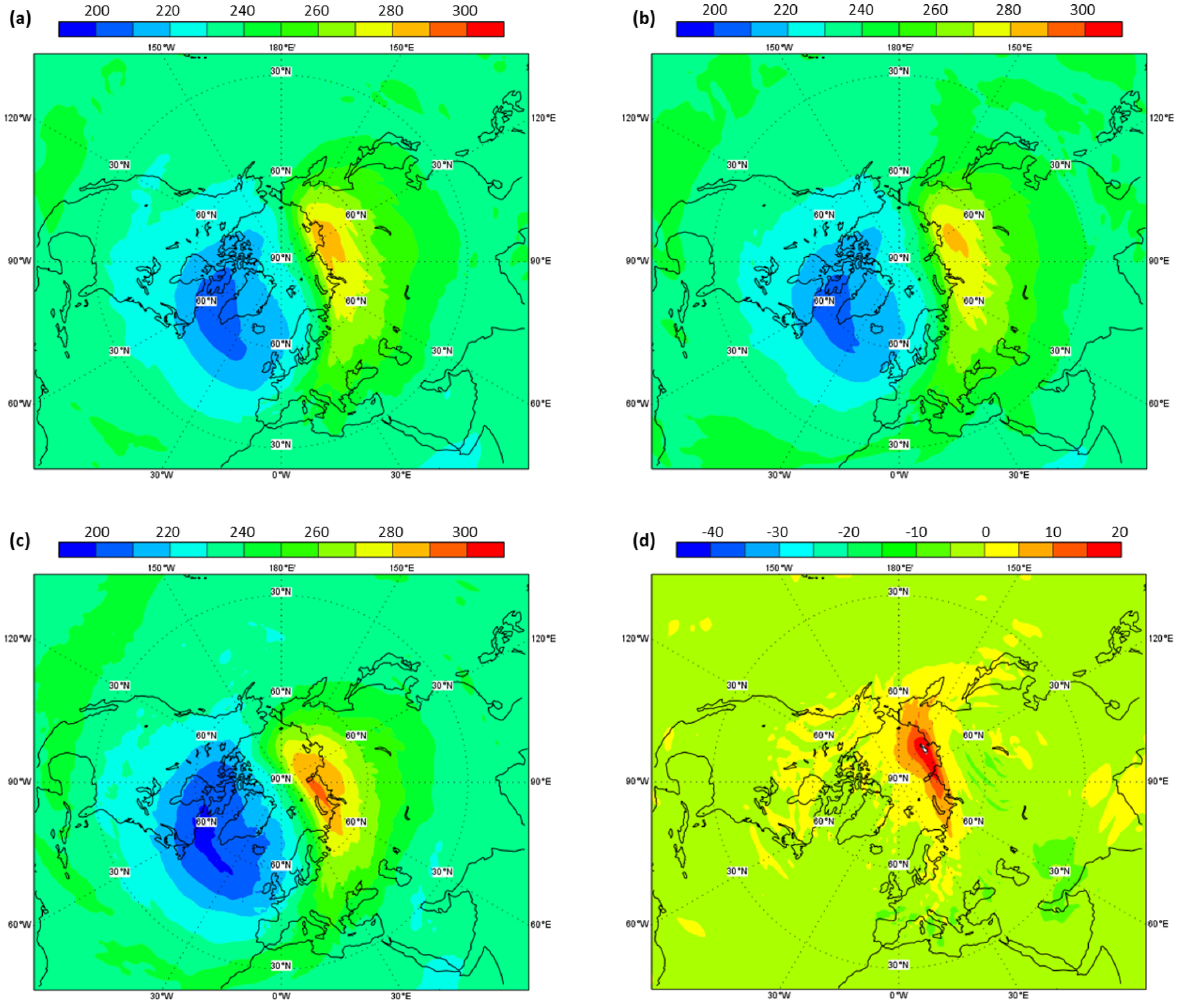
Figure 12. Temperature field on 7 February 2016 at 5hPa from (a) the forecast experiment using the new BMS ozone scheme, (b) the forecast experiment using the default ozone scheme and (c) the operational analysis. The differences between both forecast experiments (BMS – default) are shown in panel (d) . For the forecast experiments the field shown corresponds to day 10 of the forecast initialised on 28 January